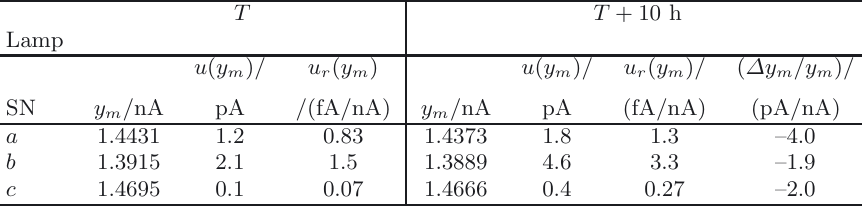
Table 1. Photocurrent value: y m ; photocurrent relative standard uncertainty u r ( y m ) and relative variation of photocurrent value, for the primary standard lamps serial numbers a , b and c , and for the instants T and T + 10 h.